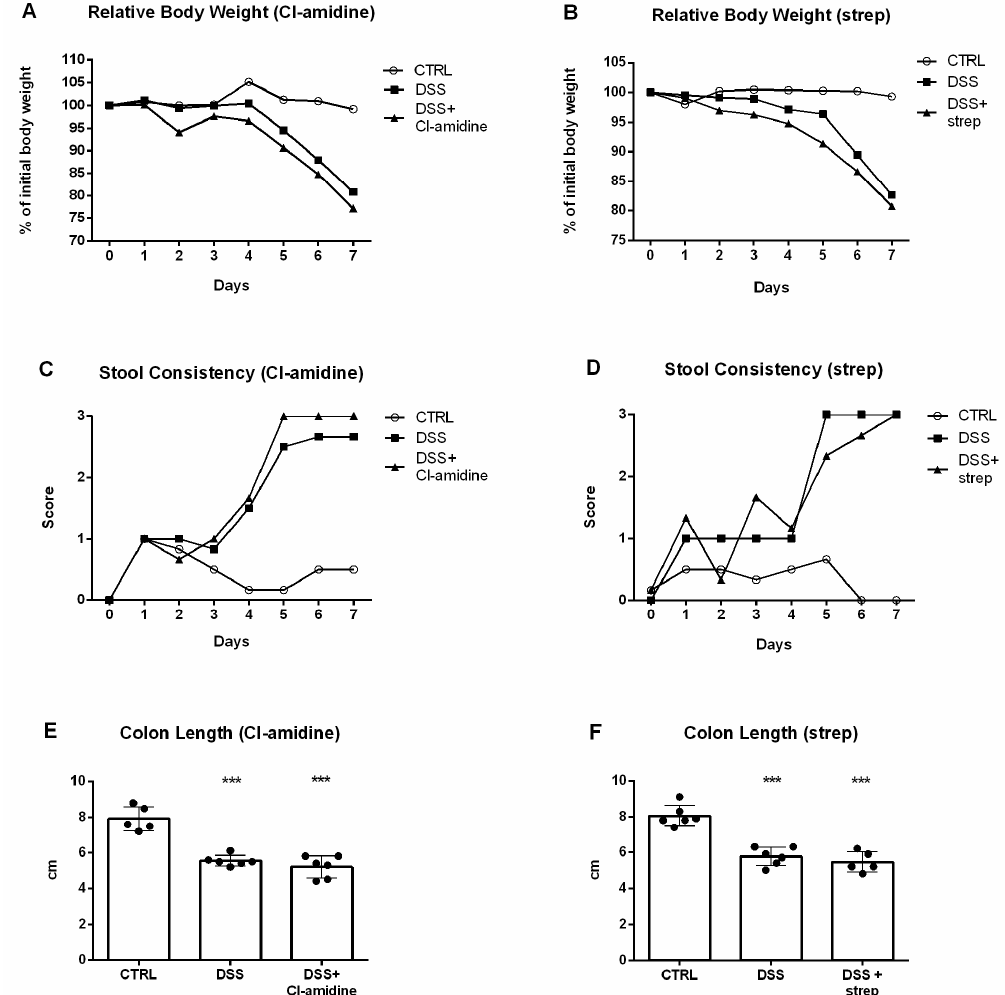
Figure 7. Comparison of Cl-amidine and streptonigrin treatment. Administration of either Cl-amidine or streptonigrin did not lead to amelioration of weight loss ( A , B ), stool consistency score ( C , D ) or colon length ( E , F ) *** = p < 0.001 .